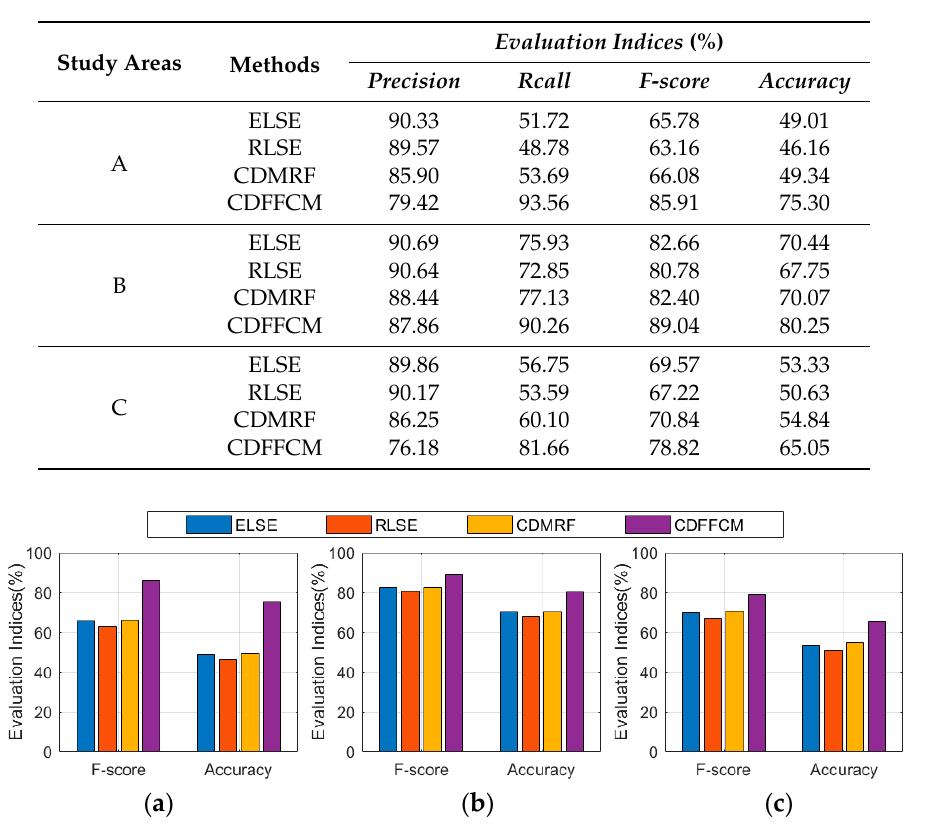
Table 5. Quantitative evaluation and comparison of different approaches for landslide mapping.